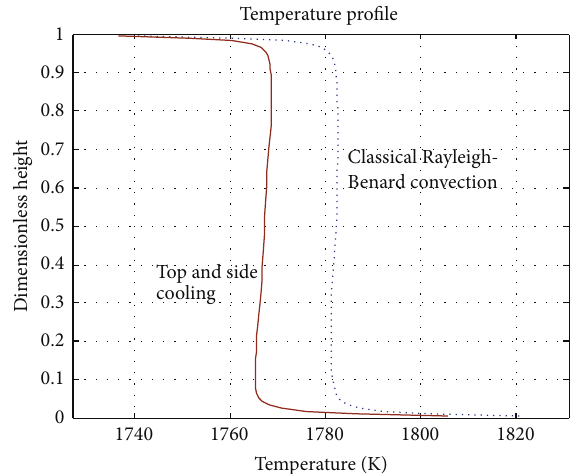
Figure 3: Temperature profiles across the fluid layer in two config- urations of cooling (with/without side cooling).